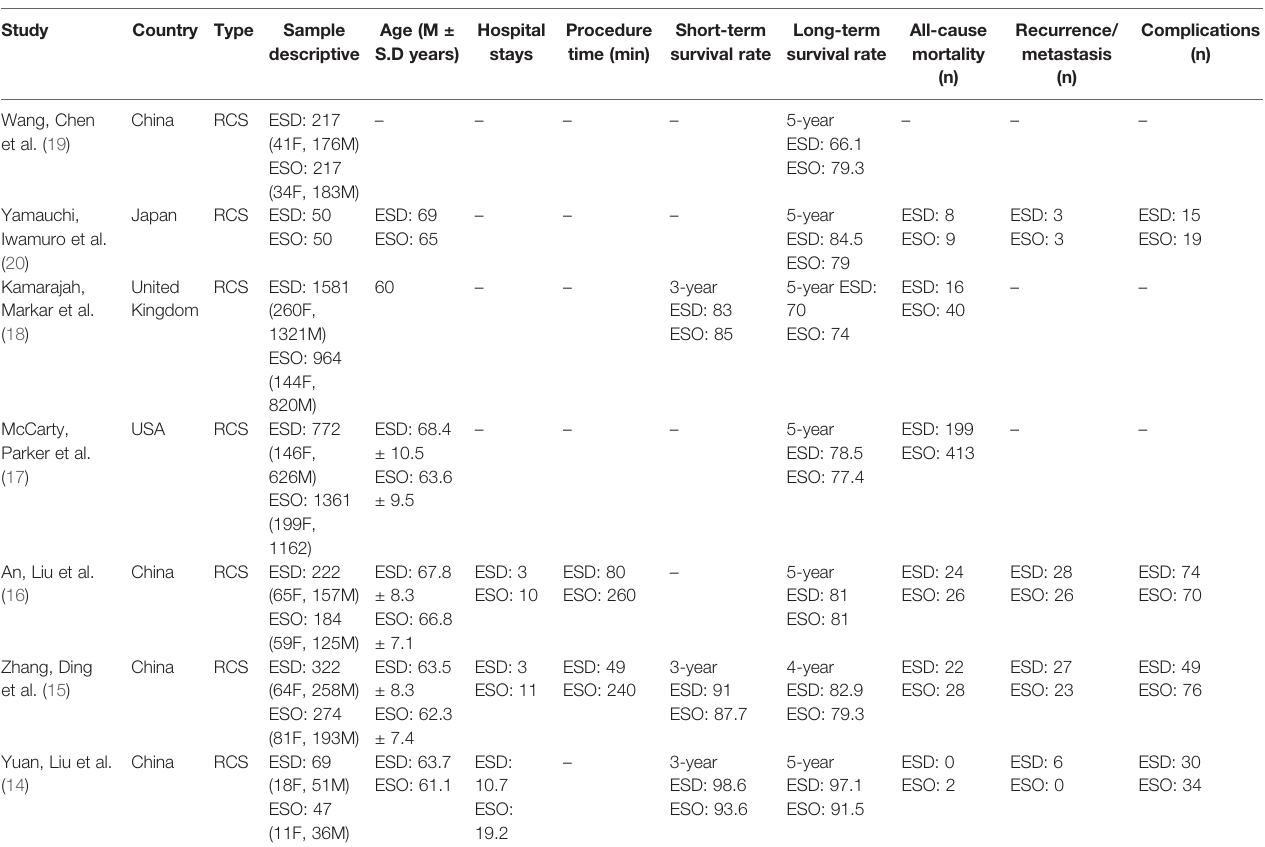
TABLE 1 | Details of the included studies. Country Type